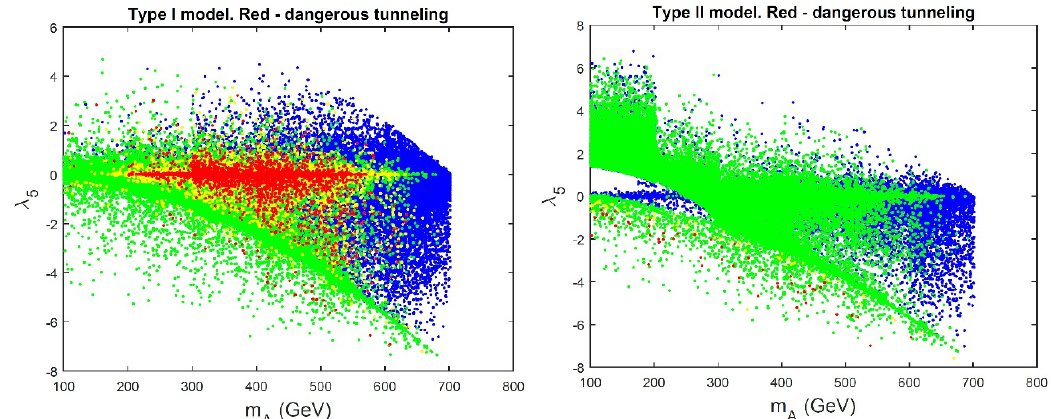
Figure 5 . Scatter plot of (cid:21) 5 vs. m A for a general scan on the parameter space of a type I (left) and type II (right) 2HDM. In blue, all points generated which conform to theoretical and experimental constraints; in green, the subset of those for which two normal vacua are possible; in yellow, the subset of those for which D < 0 and thus the EW vacuum may be the false one; and in red, those points for which the tunneling time to the true vacuum is smaller than the age of the